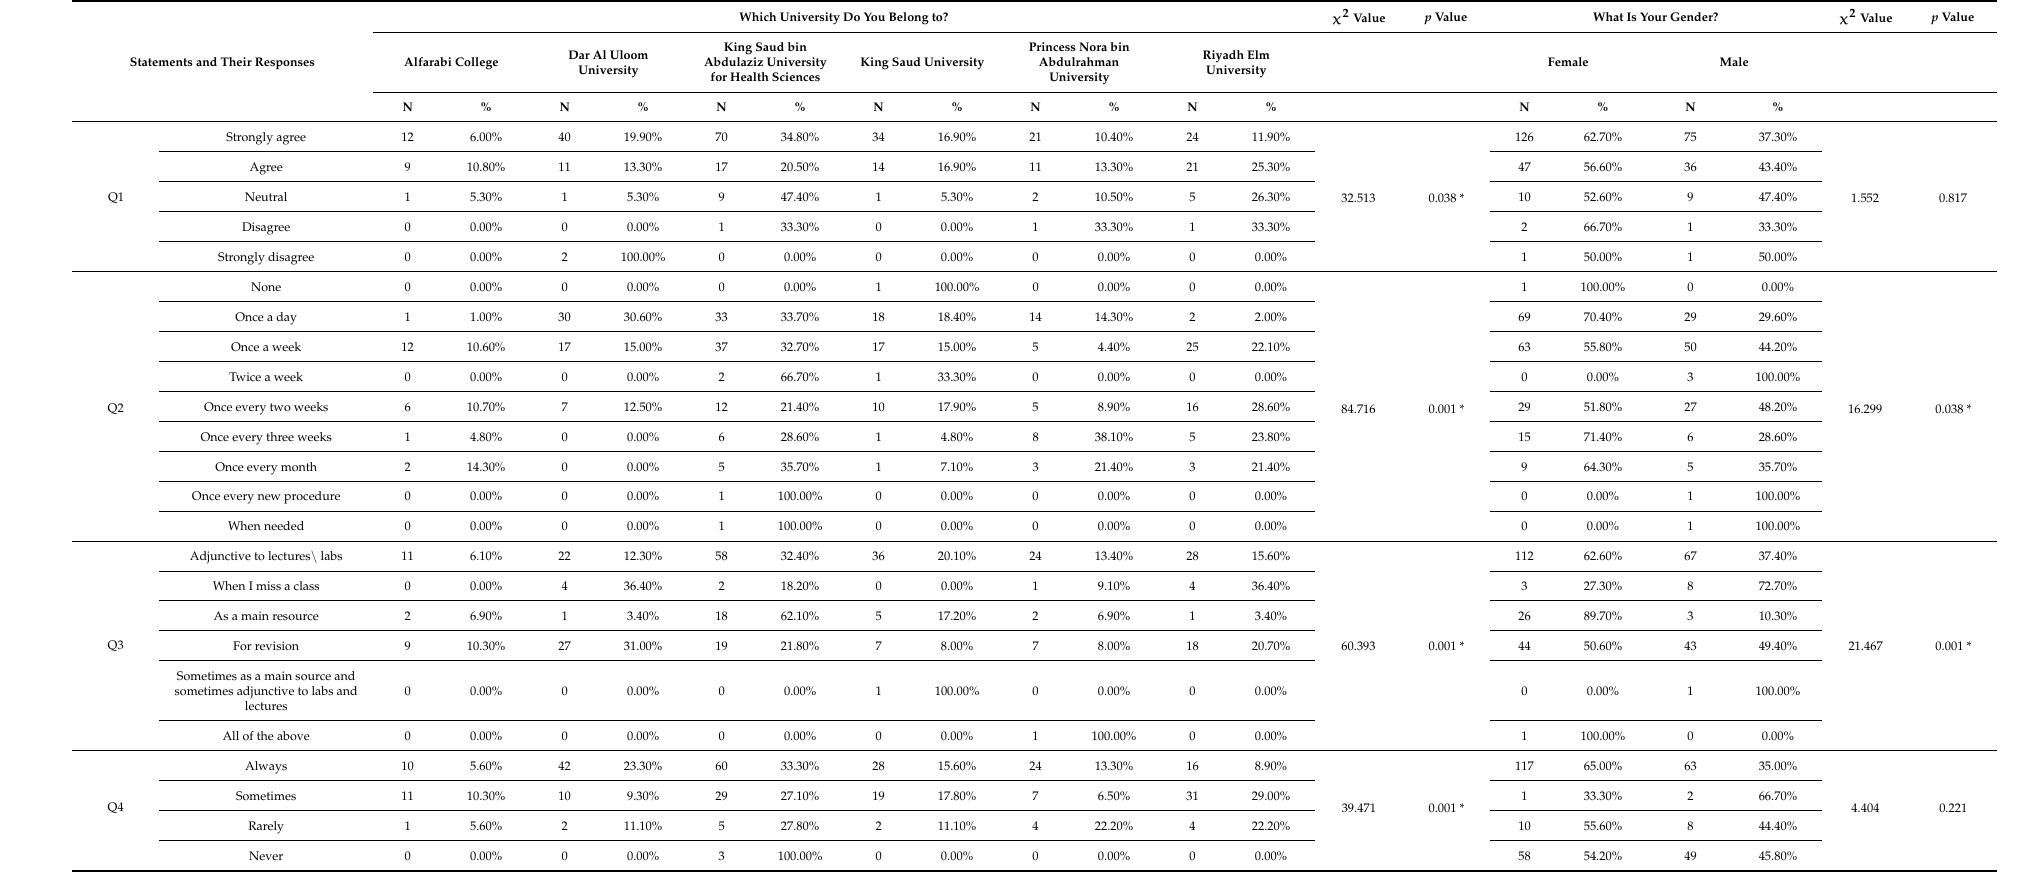
Table 3. Association of university and gender with their